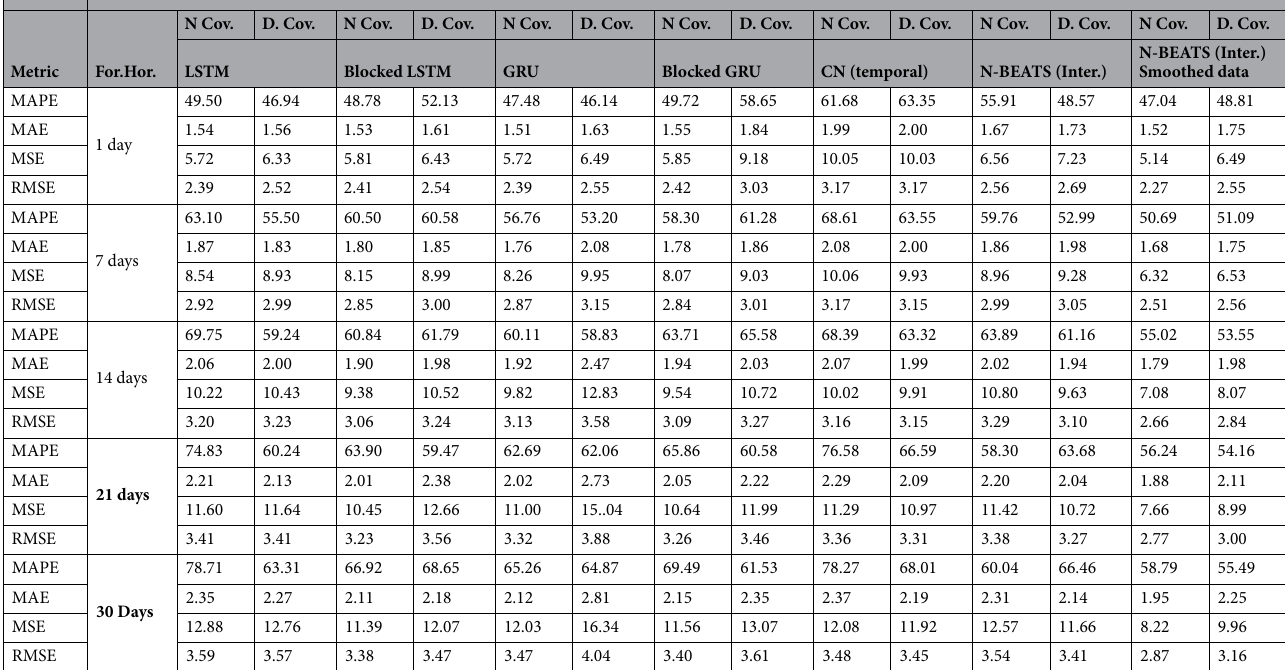
Table 3. Performance comparison of the deep learning models. For. Hor. represents the forecast horizon, N Cov. represents no covariates, while the D. Cov. denoted day as covariates. While the Inter. represents the interpretable. Significant values are in